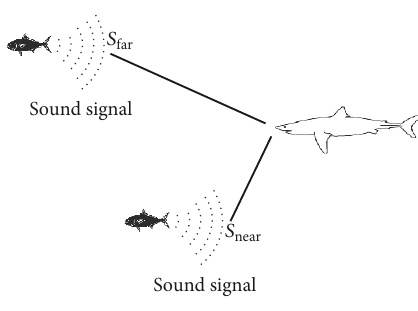
Figure 1: Random